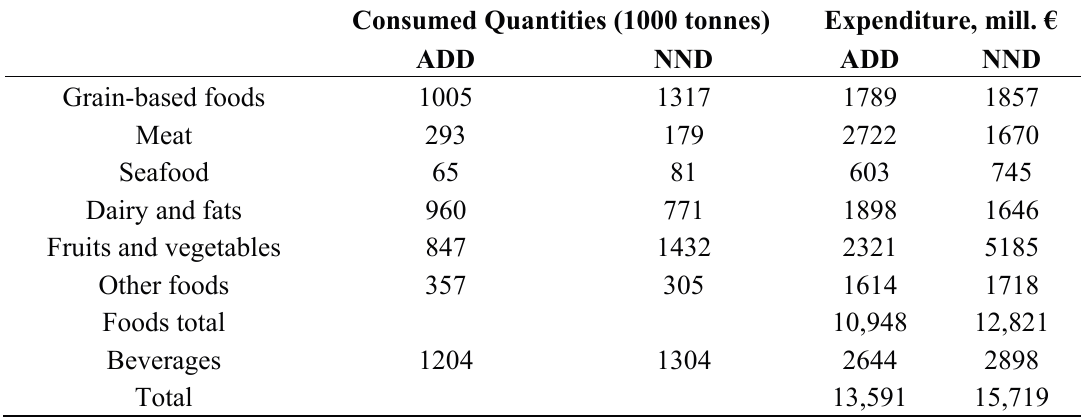
Table 1. Aggregate consumption effects, 1000 tonnes and million